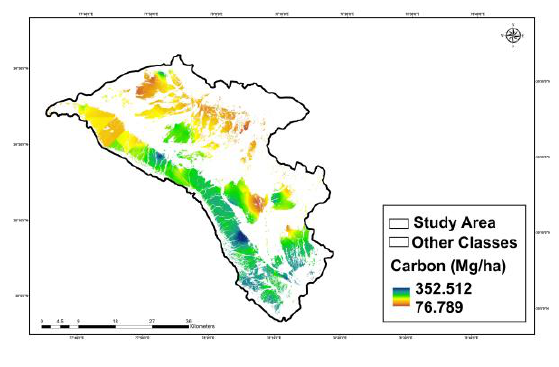
Figure 10. Carbon Prediction